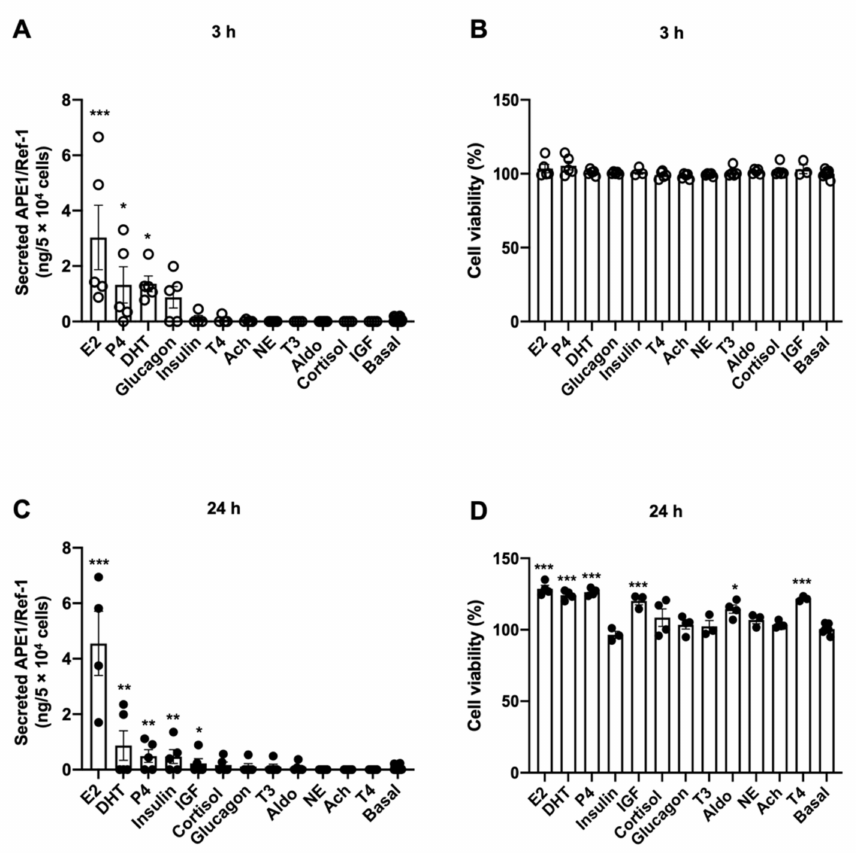
Figure 1. Identification of endogenous hormone for induction of apurinic/apyrimidinic endonuclease-1/redox factor-1 (APE1/Ref-1) secretion. ( A ) Effect of short-term (3 h) treatment of hormones on APE1/Ref-1 levels in the culture media of vascular endothelial cells. ( B ) Effect of short-term (3 h) treatment of hormones on cell viability of vascular endothelial cells. ( C ) Effect of long-term (24 h) treatment of hormones on APE1/Ref-1 levels in the culture media of vascular endothelial cells. ( D ) Effect of long-term (24 h) treatment of hormones on cell viability of vascular en- dothelial cells. Vascular endothelial cells were treated with each hormone for 3 h or 24 h. APE1/Ref-1 levels in culture supernatant were measured using an APE1/Ref-1 sandwich ELISA assay as describe Material and Methods. Columns, mean (n = 4–5); dot plot, SE. *** p < 0.001, ** p < 0.01, * p < 0.05 indicates a significant difference compared to the control cells (Basal) according to an unpaired t